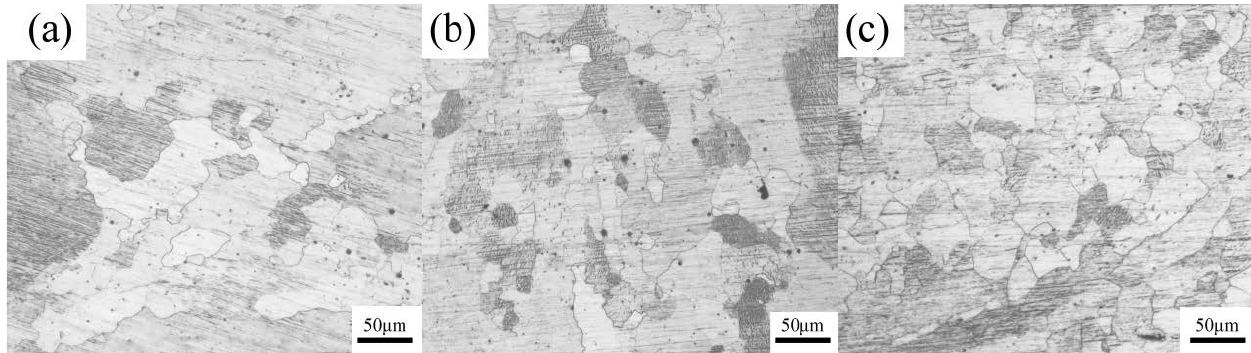
Figure 11. Microstructures at the temperature of 400 °C, the deformation rate of 60%, and various strain rates of ( a ) 0.01 s − 1 , ( b ) 0.1 s − 1 and ( c ) 1 s − 1.